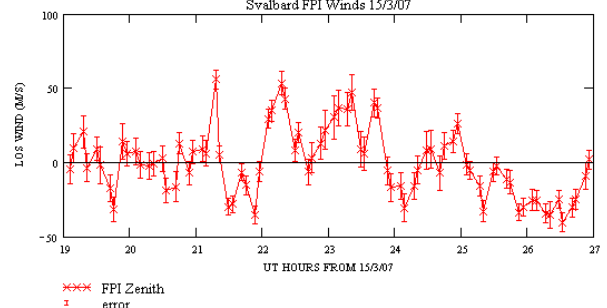
Fig. 5. FPI zenith wind measurements for 15 March 2007. Positive winds indicate